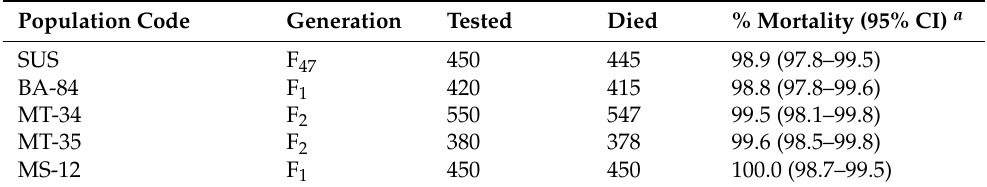
Table 3. Mortality of Helicoverpa armigera populations at the diagnostic concentration of HearNPV (6.9 × 10 8